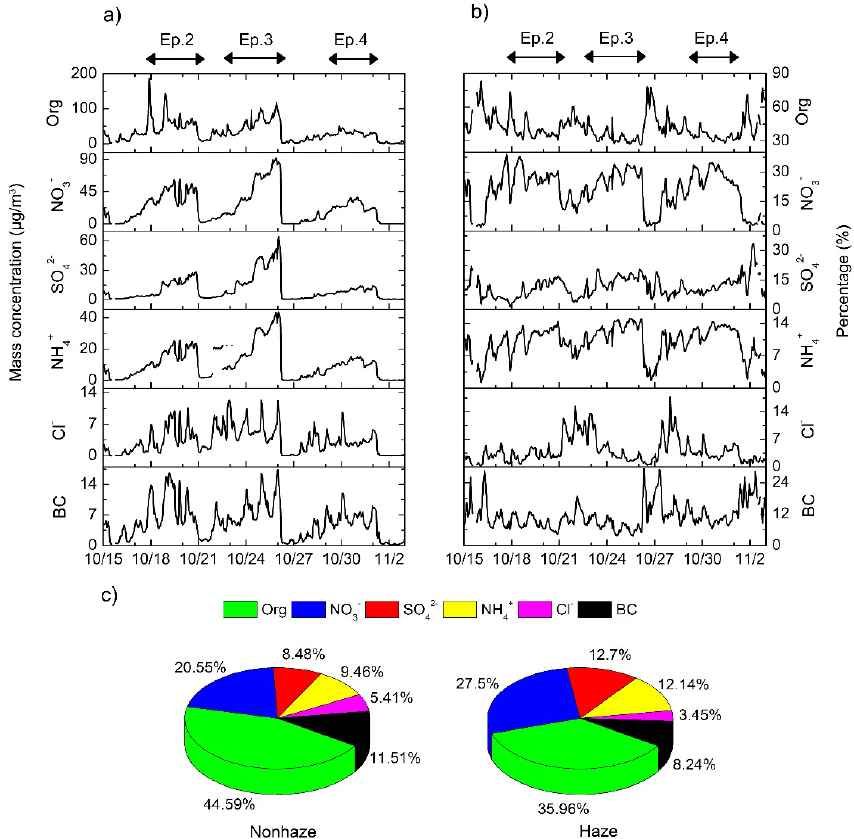
Figure 6. (a) Temporal variation of the mass concentration of each aerosol species in PM 1 , (b) temporal variation of the mass fraction of each aerosol species in PM 1 , (c) mass fraction of each aerosol species in PM 1 during non-haze and haze episodes from 15 October to 2 November